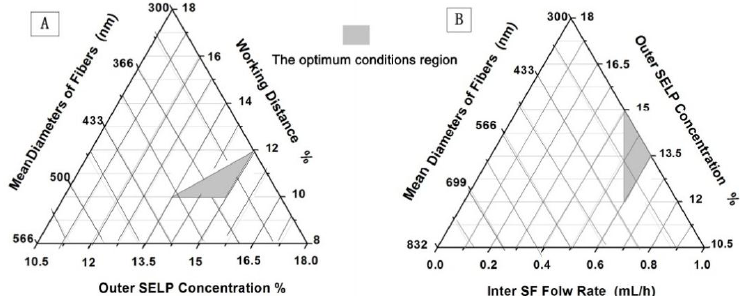
Figure 6. Conditions where to electrospin uniform SF-SELP nanofibers were generated: ( A ) mean diameters of fibers (nm) with outer SELP concentration (%) and working distance (cm); ( B ) mean diameters of fibers with inner flow rates (mL/h) and outer SELP concentration (%).